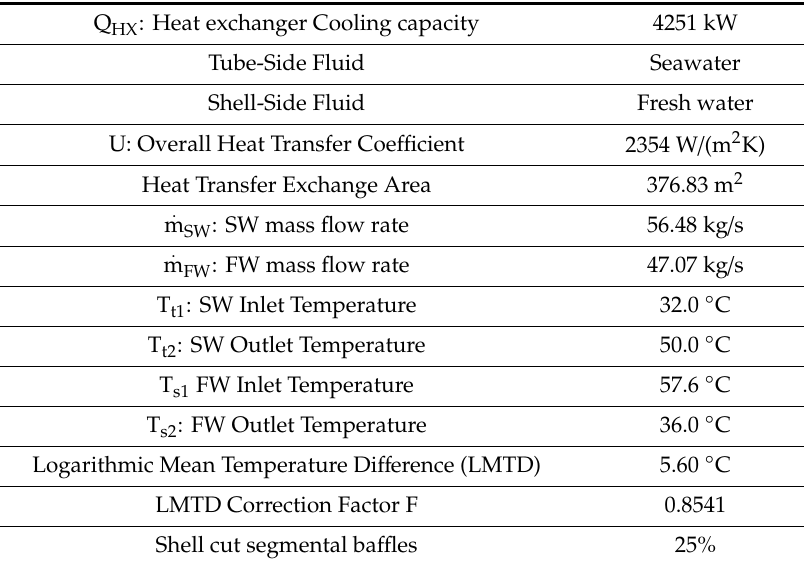
Table 1. Design Conditions of the Central Cooler Heat Exchanger